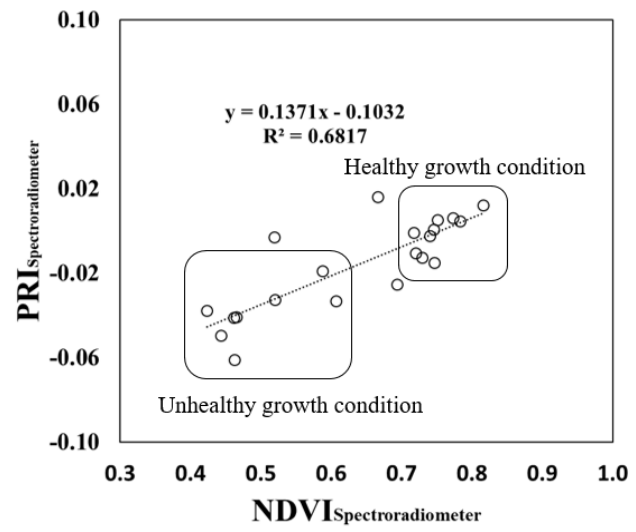
Figure 15. Correlation between NDVI and PRI obtained using a spectroradiometer.